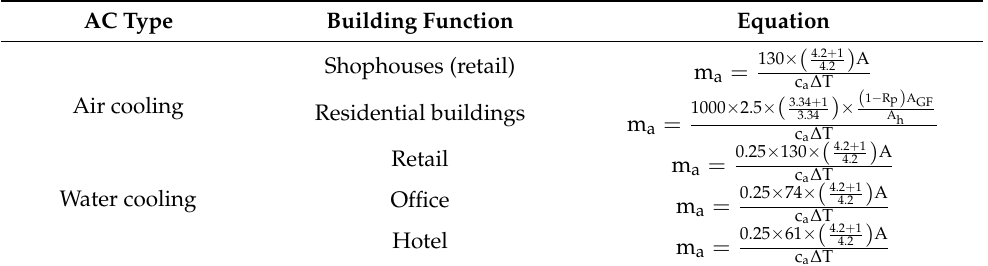
Table A1. Equations to calculate m a for buildings with different AC types and functions.